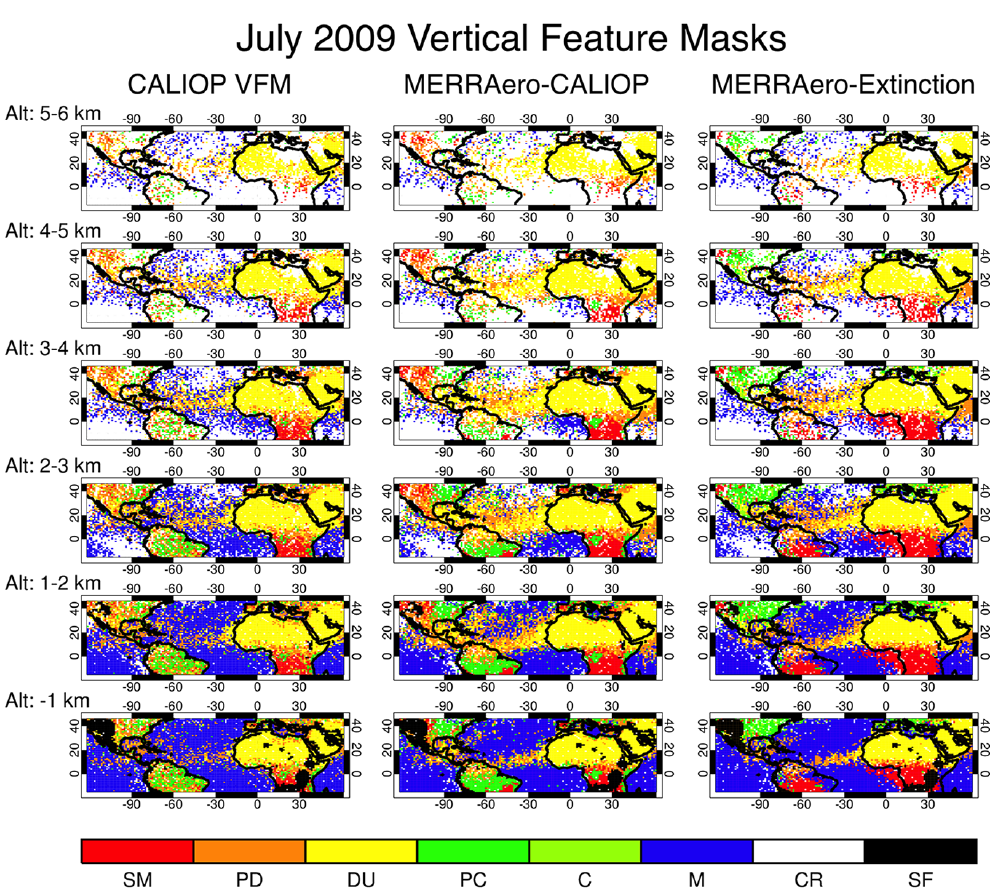
Figure 7. (a–f) CALIOP (left), MERRAero-CALIOP (center), and MERRAero-Extinction (right) VFMs at 1km intervals for July 2009. Aerosol types include smoke (SM), polluted dust (PD), desert dust (DU), clean continental (C), and marine (M). The surface (SF) and regions with no data (ND) are also